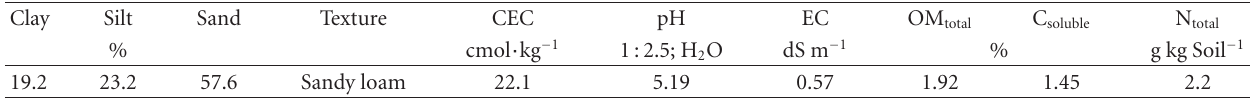
Table 2: Physical and chemical properties of the Biosolid Compost used as organic amendment. (DM: dry mater). CEC pH EC OM total C soluble N total C/N (cmol · kg − 1 ) (1:2.5; H 2 O) dS m − 1 (%) (gkg Soil − 1 ) 14.3 7.5 1.29 4.25 0.031 0.32 13.2 OM total : total organic matter; C soluble : soluble carbon; N total : total nitrogen; C/N: carbon-nitrogen